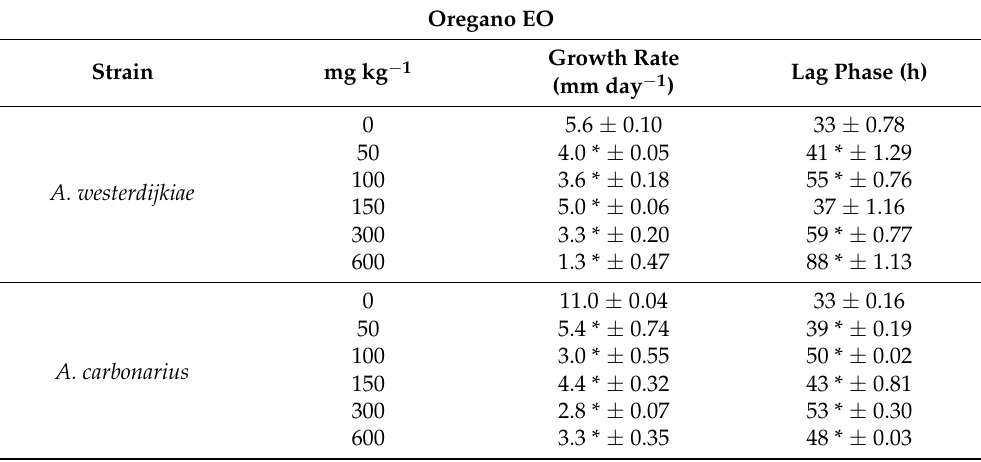
Table 5. Effect of oregano essential oil on lag phase and growth rate of A. westerdijkiae and A. carbonar- ius at different